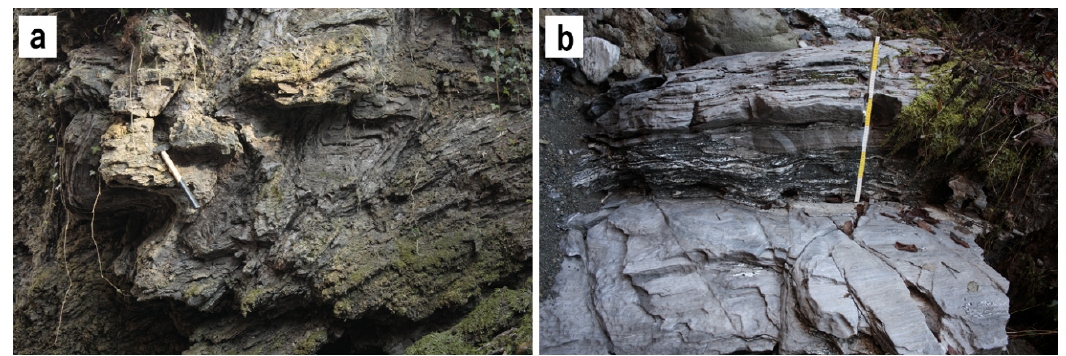
Figure 3. Evaporites outcrop in the hilly areas north of Quinis village. ( a ) Small folds highlighting